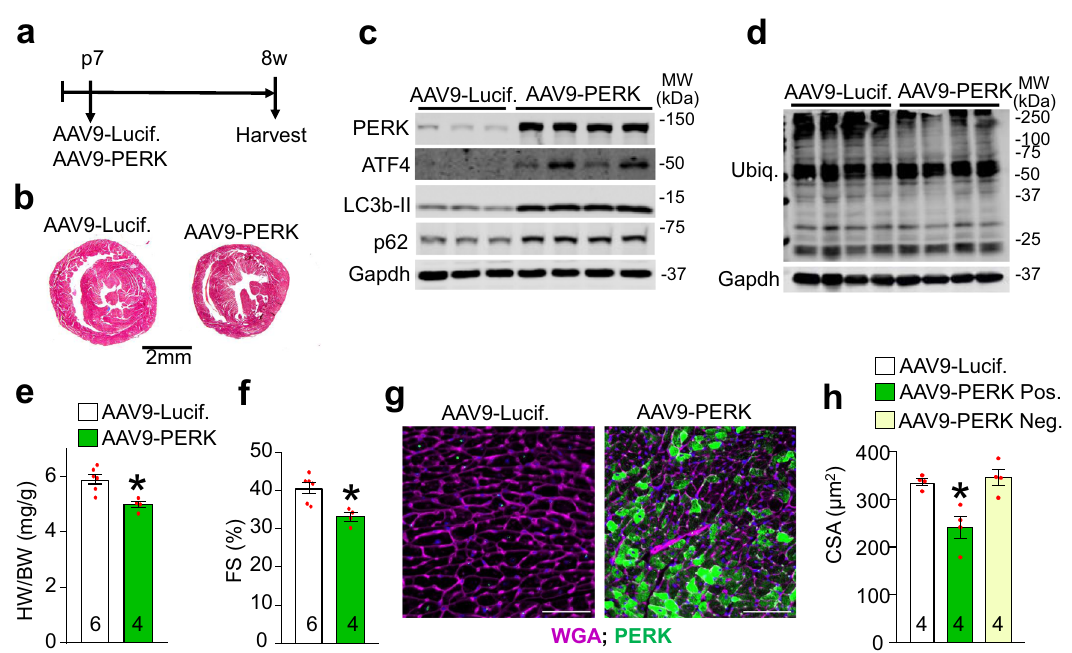
Fig. 8 Overexpression of PERK mediates cardiac atrophy. a Schematic diagram depicting the experimental protocol. Either 1E11 genomic copies of adeno- associated virus 9 (AAV9)-PERK or AAV9-luciferase (Lucif.) control were injected into the mediastinum of 7-day-old WT mouse pups. Hearts were harvested at 8 weeks of age for further analysis. b Low magni fi cation of whole mount cardiac histological images from mice injected with AAV9-PERK or AAV9-Lucif. control stained with Masson ’ s trichrome at 8 weeks of age. Scale bar is 2mm. c Representative western blots for PERK, ATF4, LC3b, and p62 from cardiac protein extracts of 8-week-old mice injected with either AAV9-Lucif. or AAV9-PERK. Gapdh serves as a loading control. d Representative western blot for ubiquitin-conjugated proteins (Ubiq.) and Gapdh as loading control on cardiac protein extracts of 8-week-old mice injected with either AAV9-Lucif. or AAV9-PERK. e HW/BW ratio (* P = 0.0051 vs AAV9-Lucif.) and f FS% at 8 weeks of age in the 2 indicated groups of mice. * P = 0.0060 vs AAV9-Lucif. g Representative immunohistochemistry for PERK (green), nuclei with DAPI (blue) and WGA (purple)-stained membranes from heart sections of AAV9-PERK or AAV9-Lucif. injected mice killed at 8 weeks of age. Scale bars are 100 μ m. h Quantitative analysis of AAV9-Lucif. versus or AAV9-PERK positive (Pos.) and negative (Neg.) cross sectional area (CSA) determined by WGA staining of cardiac histological sections. * P = 0.0087 vs AAV9-Lucif. and * P = 0.0050 vs AAV9-PERK Neg. The number of biologically independent animals analyzed are indicated on the graphs. Statistical analysis was performed using a two-tailed Student ’ s t -test in panels “ e , f ” , and one-way ANOVA and Tukey multiple comparisons test in panel “ h ” . All error bars are ±standard error of the mean. Source data are provided as a Source Data